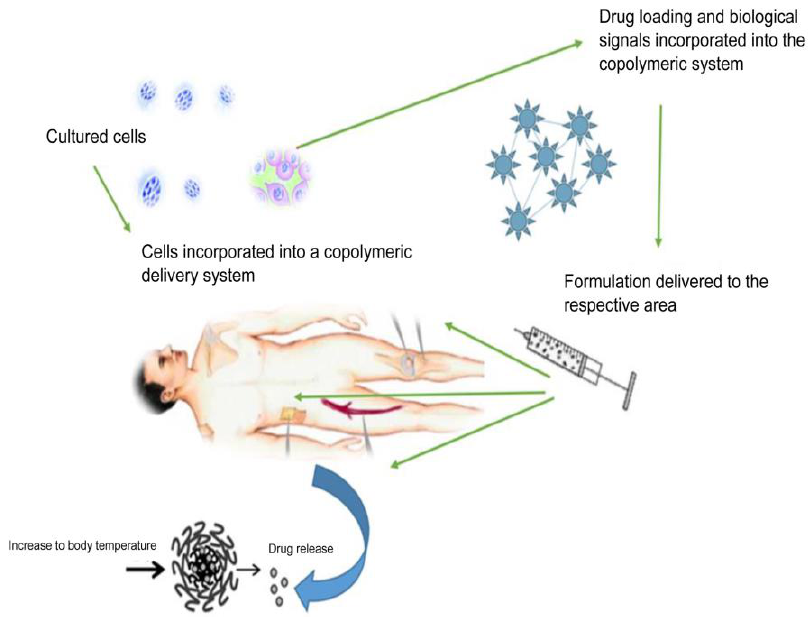
Figure 5. Schematic representation of tissue engineering application, delivering drug-loaded thermo-sensitive polymers with bioactive signals.